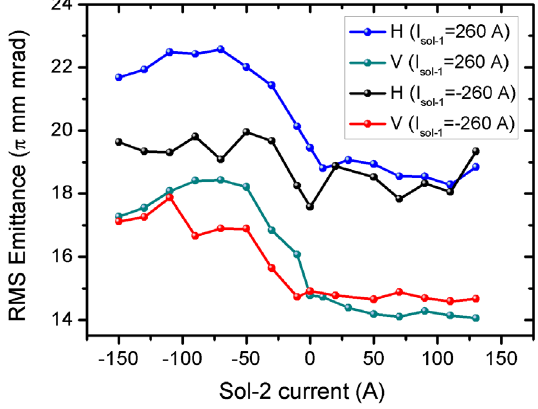
FIG. 8. Measured beam emittances at